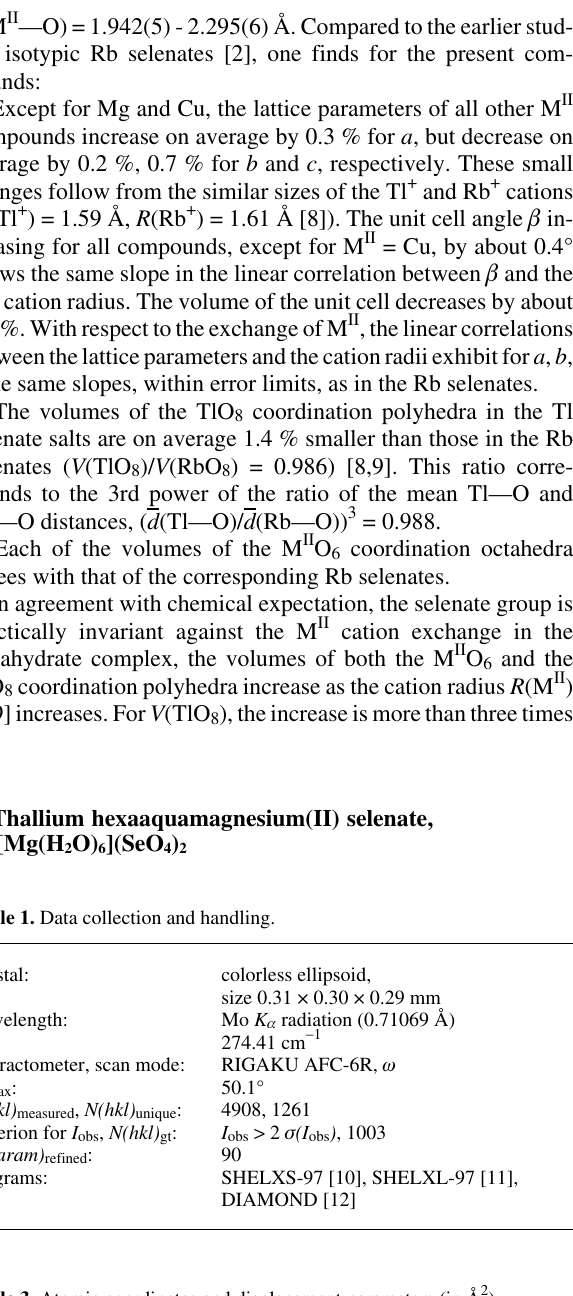
Table 3. Atomic coordinates and displacement parameters (in Å 2 ) .